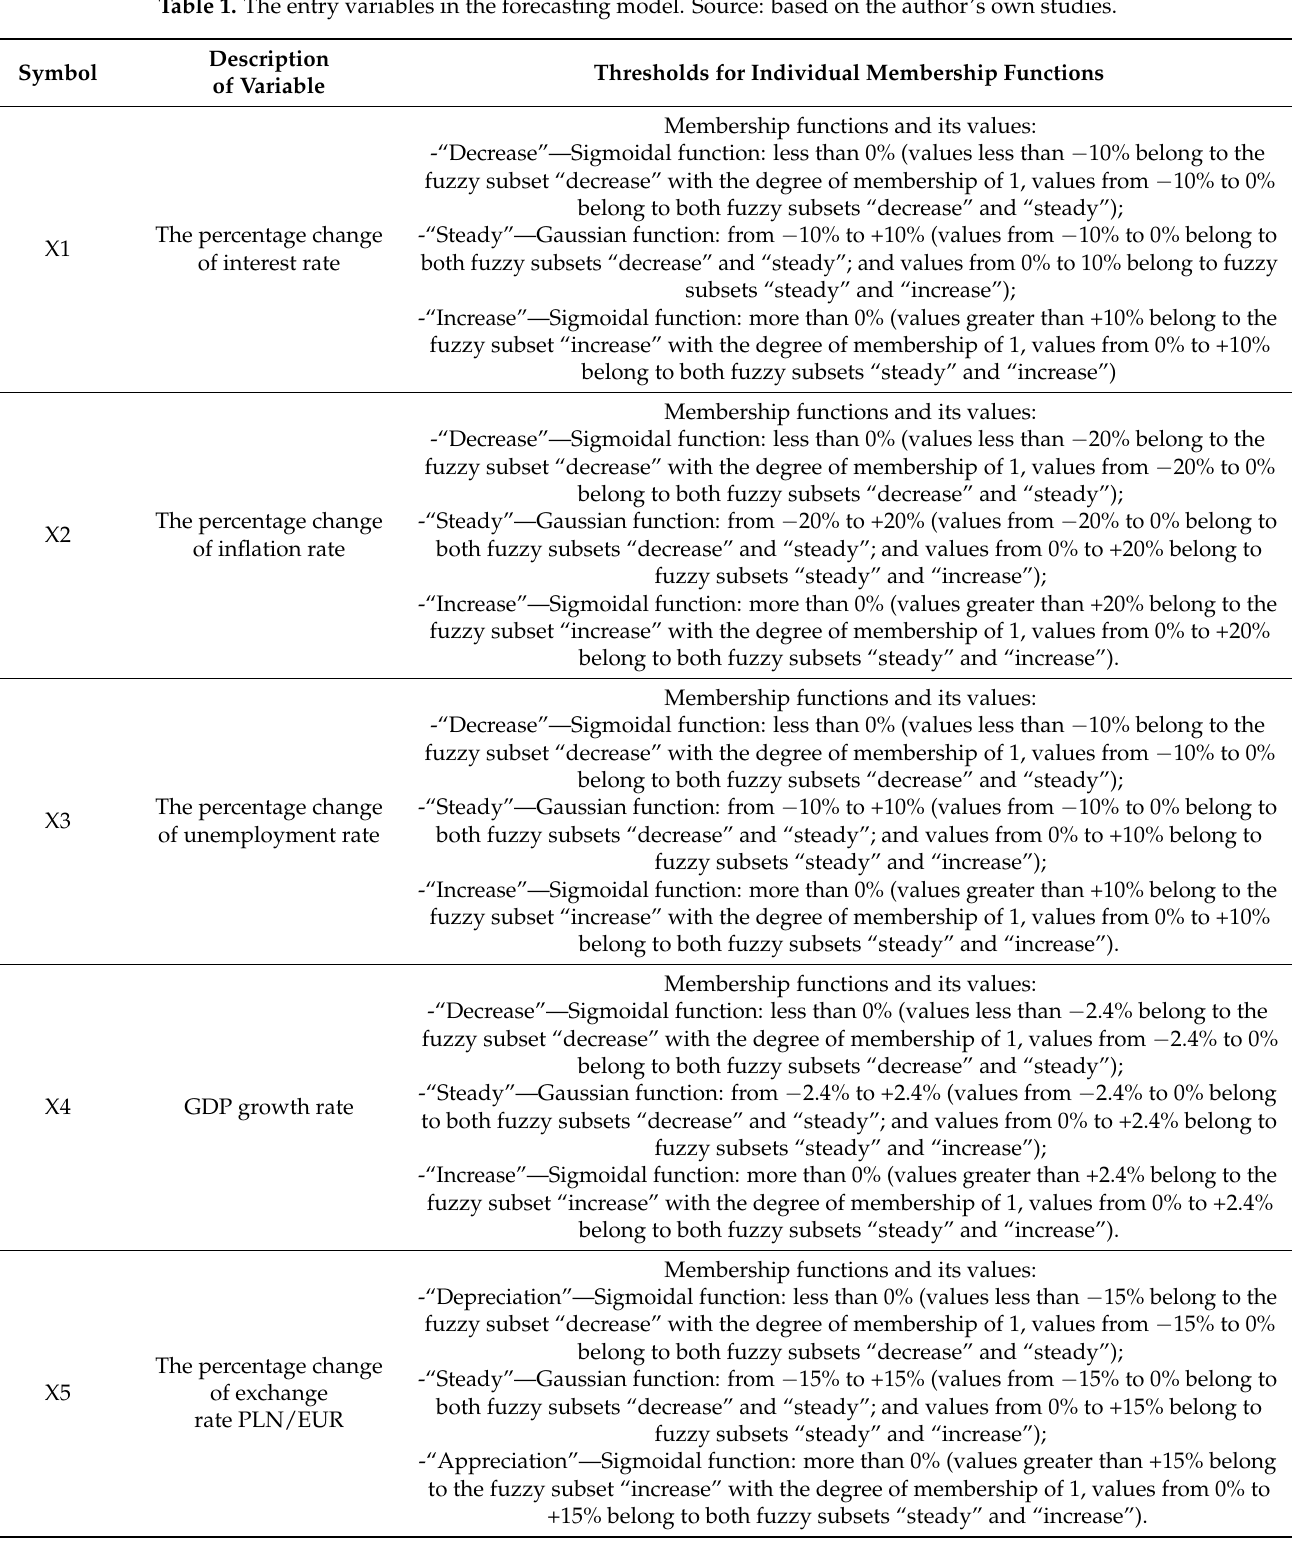
Table 1. The entry variables in the forecasting model. Source: based on the author’s own